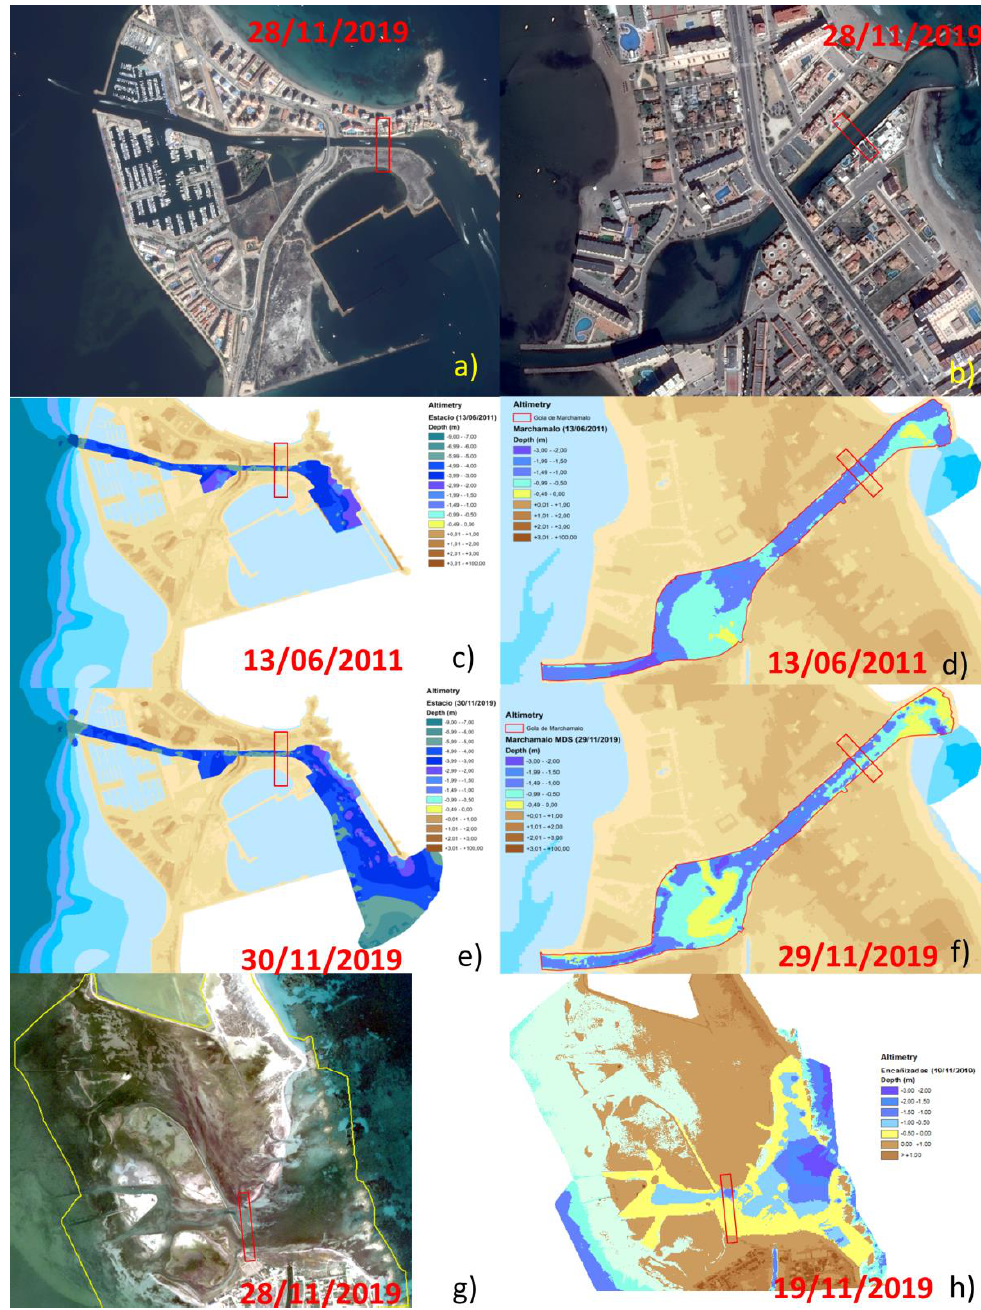
Figure 17. The monitoring of the sediment deposit: ( a , c , e ) El Estacio channel; ( b , d , f ) Marchamalo channel; and ( g , h ) Encañizada channel. The yellow areas correspond to depths less than 0.5 m. The rectangle red represents the zone of comparison between the bathymetries in the